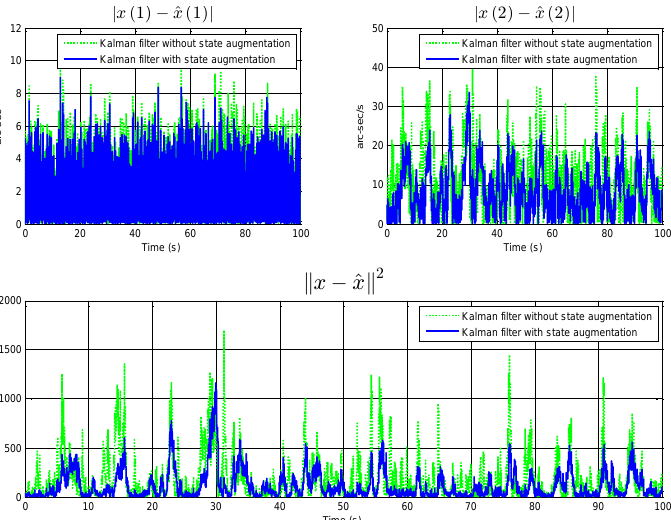
Figure 2. Comparison of estimation errors between SKF and improved KF using state